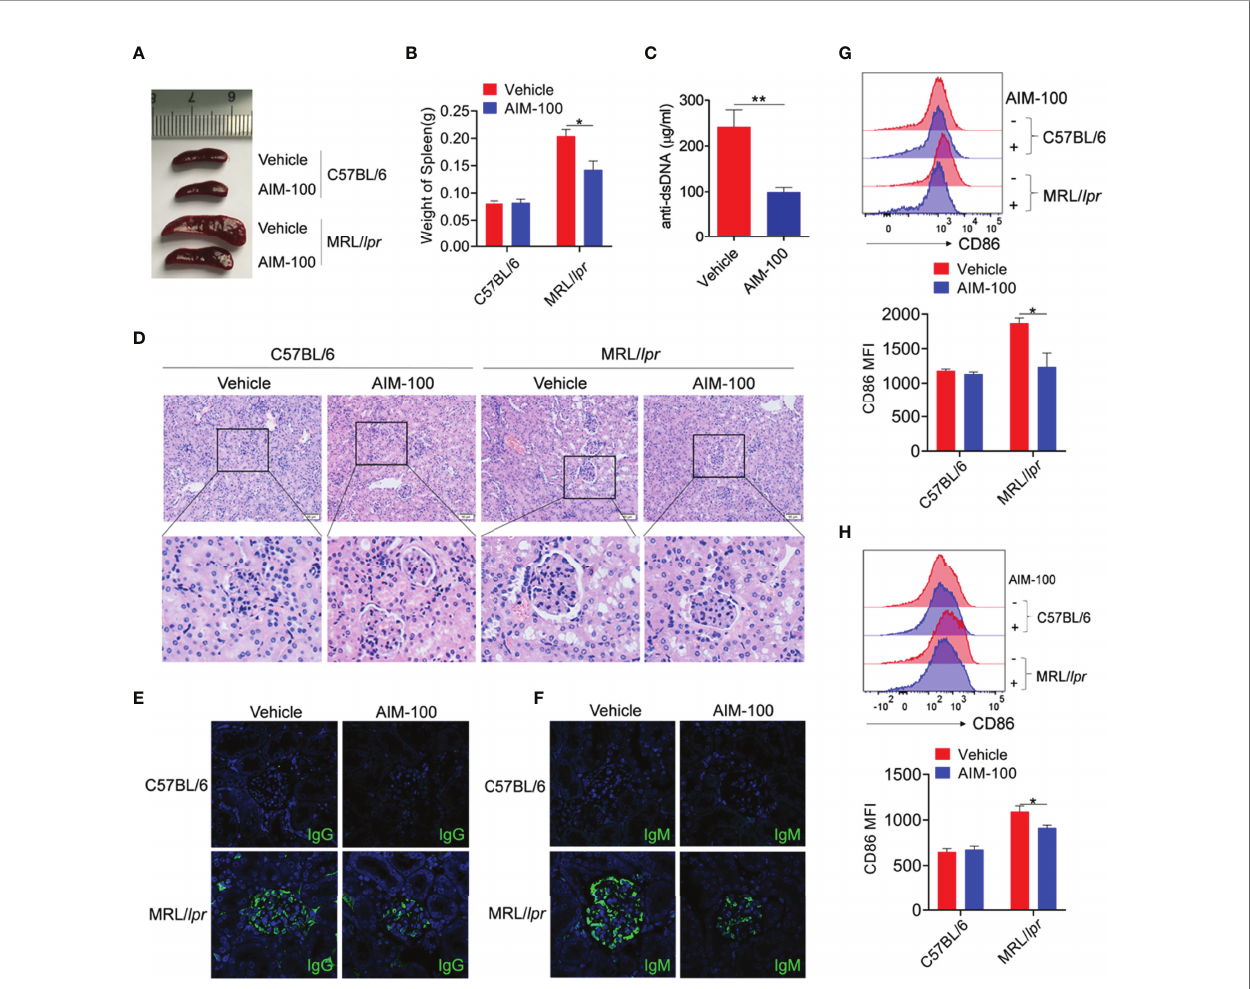
FIGURE 7 | The ACK1 inhibitor AIM-100 alleviates the conditions of MRL/ lpr lupus-prone mice. (A) The representative spleen images in all group of mice. (B) The weight of spleens in all group of mice. (C) ELISA was performed to analysis of anti-dsDNA antibodies in serum. (D) H&E staining of the kidney sections from all groups of mice. (E, F) The IgG (E) and IgM (F) deposit in the kidney sections was detected by immuno fl uorescence. The scar strip represents 50 m m. (G, H) FACS analysis of the expression of CD86 on splenic macrophages (G) and DCs (H) . Results represented as mean ± SEM (n=5 mice/group). * p < 0.05, ** p < 0.01, as determined by ANOVA or Student ’ s t